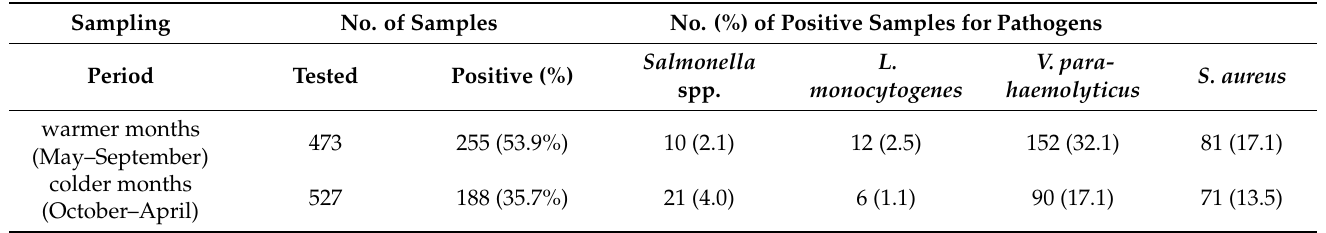
Table 5. Seasonal distribution of bacterial pathogens in bivalve molluscs tested during